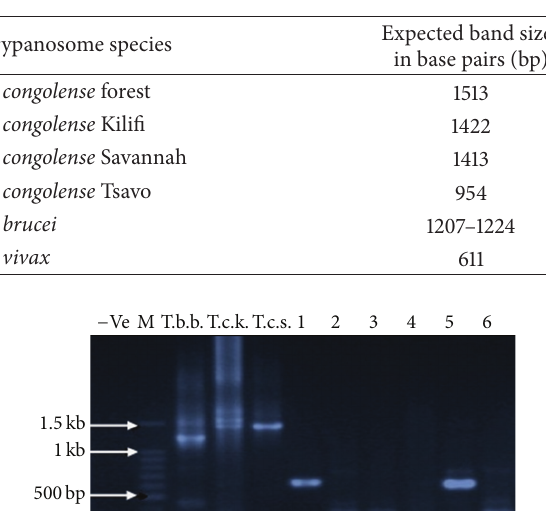
Figure 7: An image of an agarose gel showing PCR amplified DNA fragments using ITS nested PCR